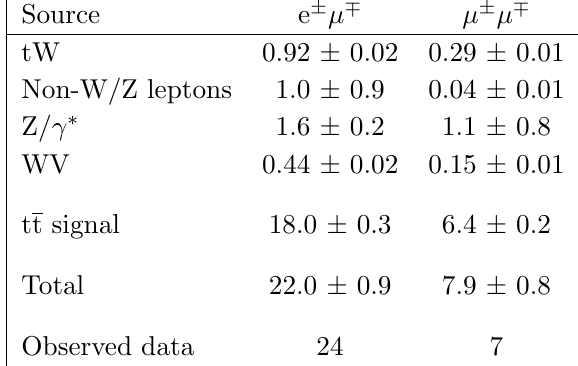
Table 3 . The predicted and observed numbers of dilepton events obtained after applying the full selection. The values are given for the individual sources of background, tt signal, and data. The uncertainties correspond to the statistical component.